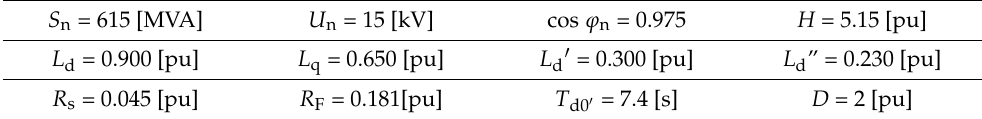
Table A4. Manufacturer’s data: hydro-type synchronous generator S n = 615 MVA.